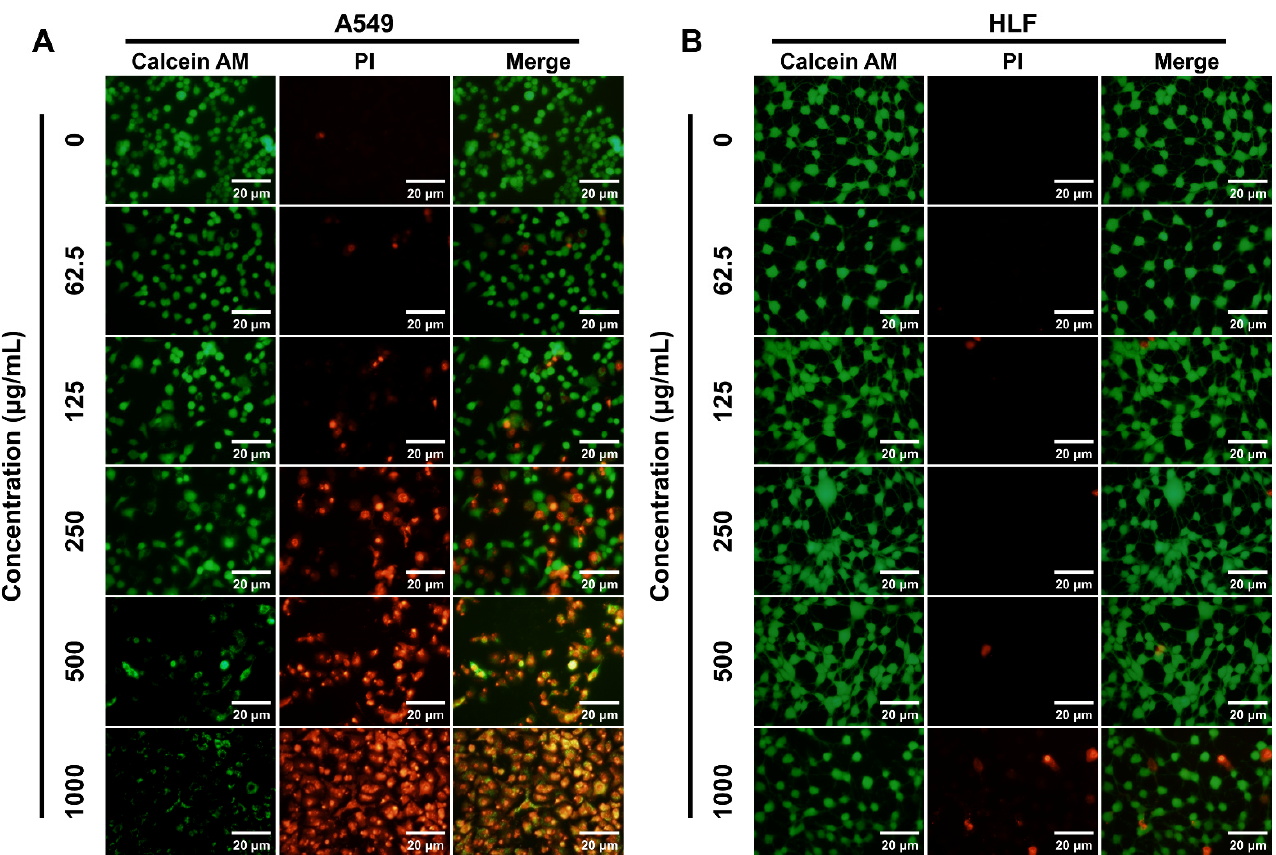
Figure 2. ( A ) A549 and ( B ) HLF cells with different concentrations of K ₄ F ₆ K ₄ for 12 h and dyed by calcein AM and PI to distinguish live cells from dead cells. The green fluorescence represents living cells and the red fluorescence represents dead cells. The scale bar represents 20 μ m.